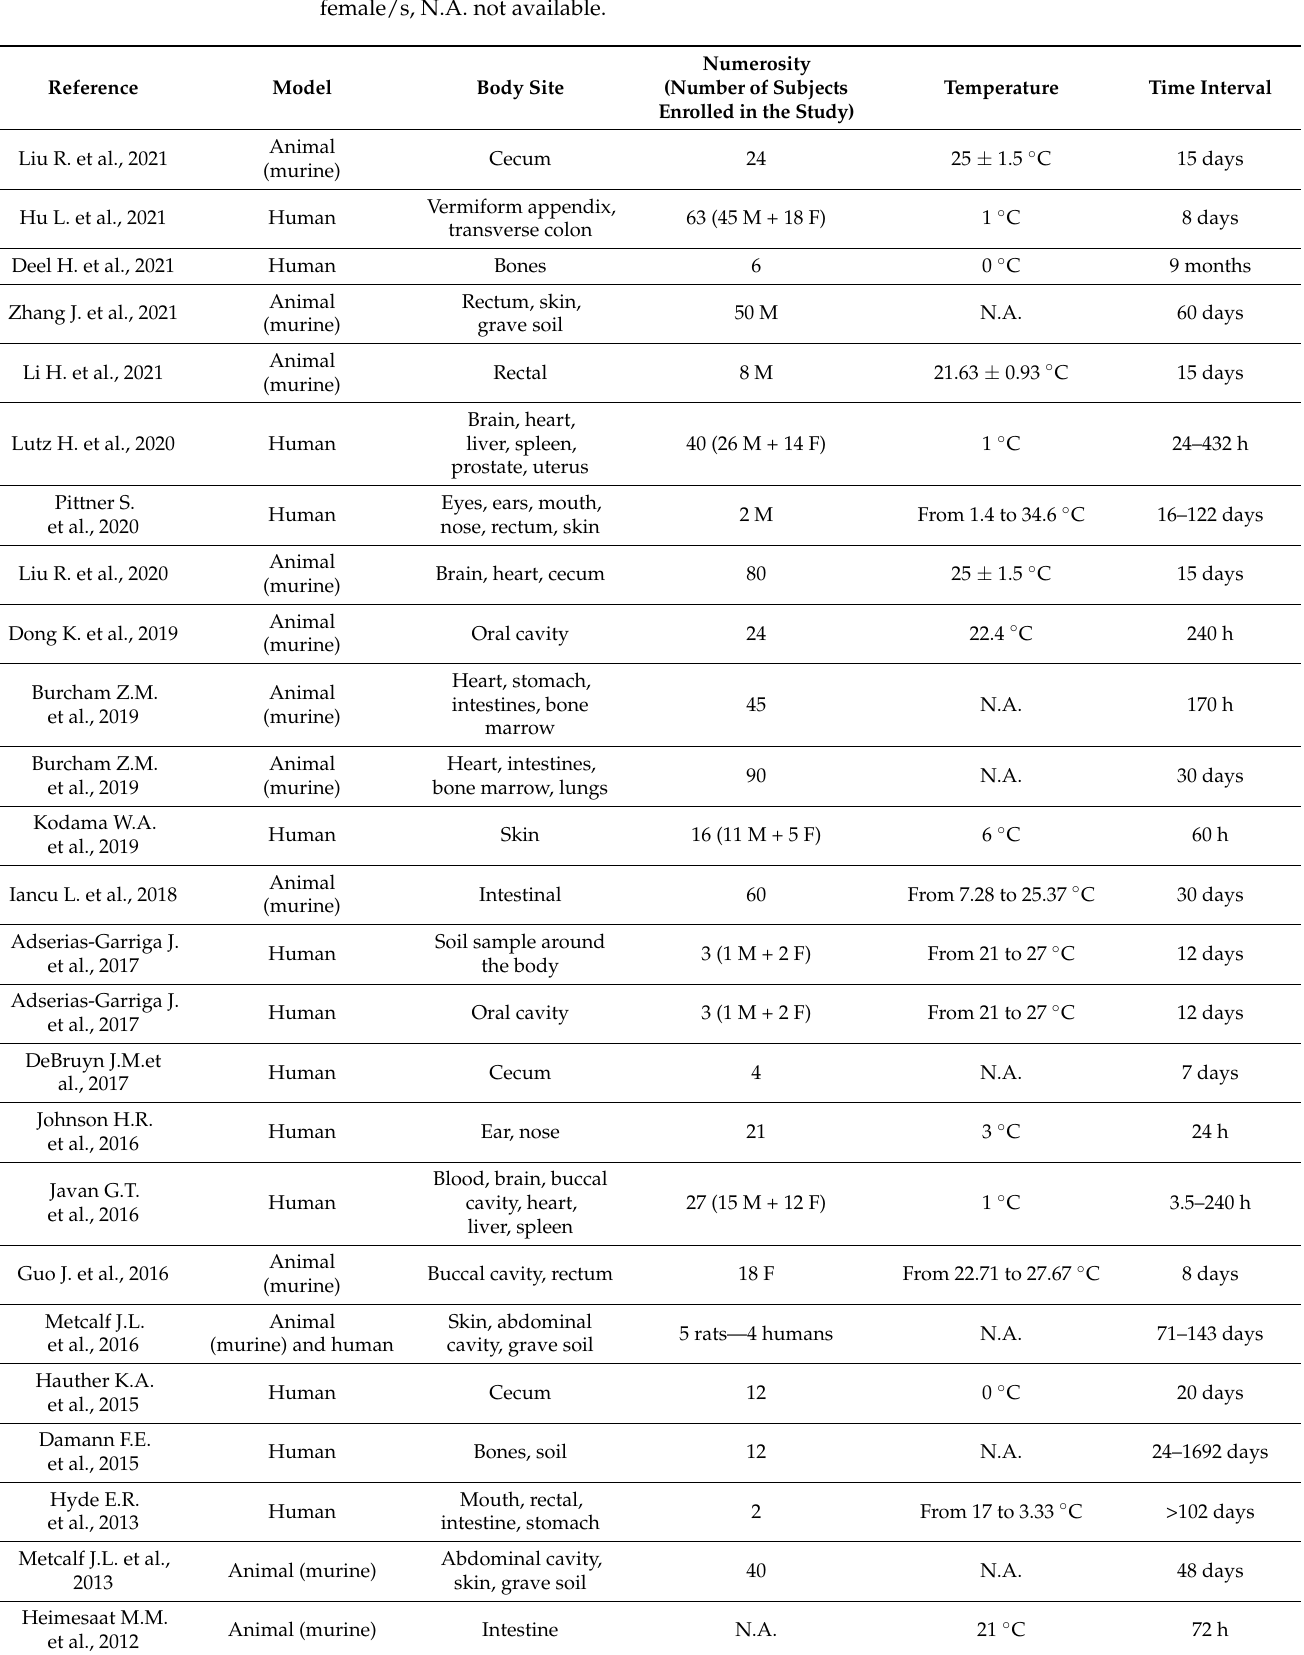
Table 1. Summary of the main characteristics of the studies included in the review. M: male/s, F: female/s, N.A. not